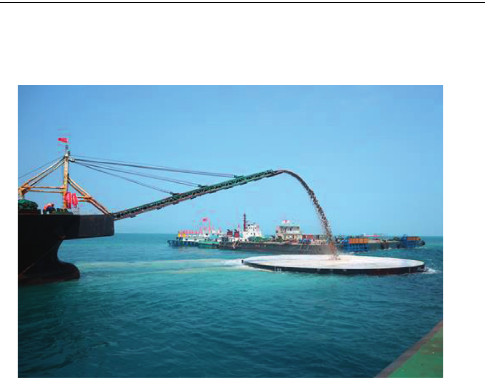
Figure 27: Backfilling